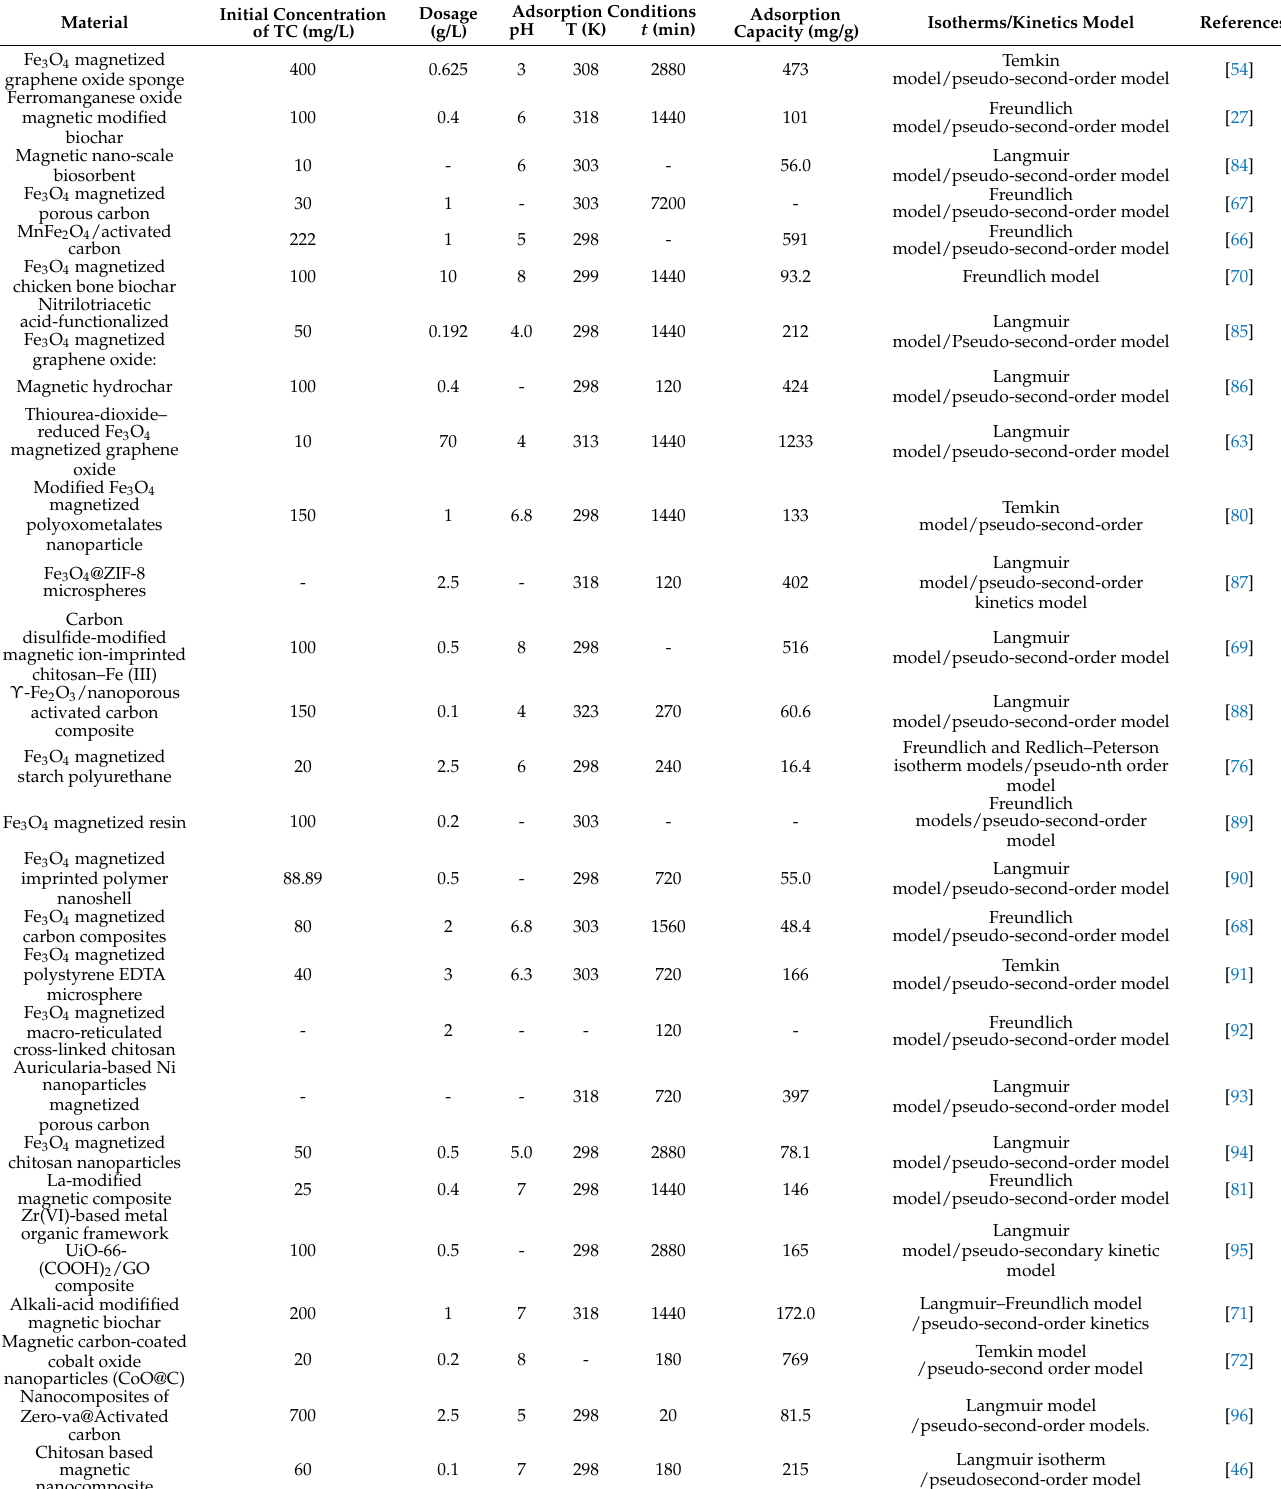
Table 2. Performance of diverse magnetic materials for TC